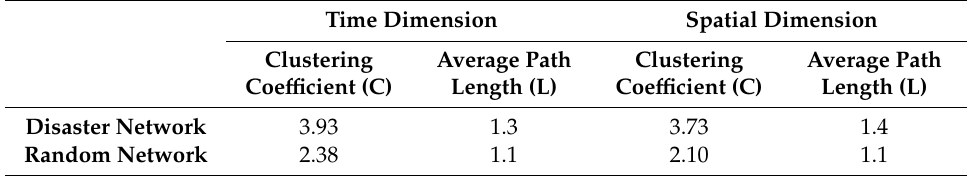
Table 1. Analysis result of the small-world nature of the Typhoon